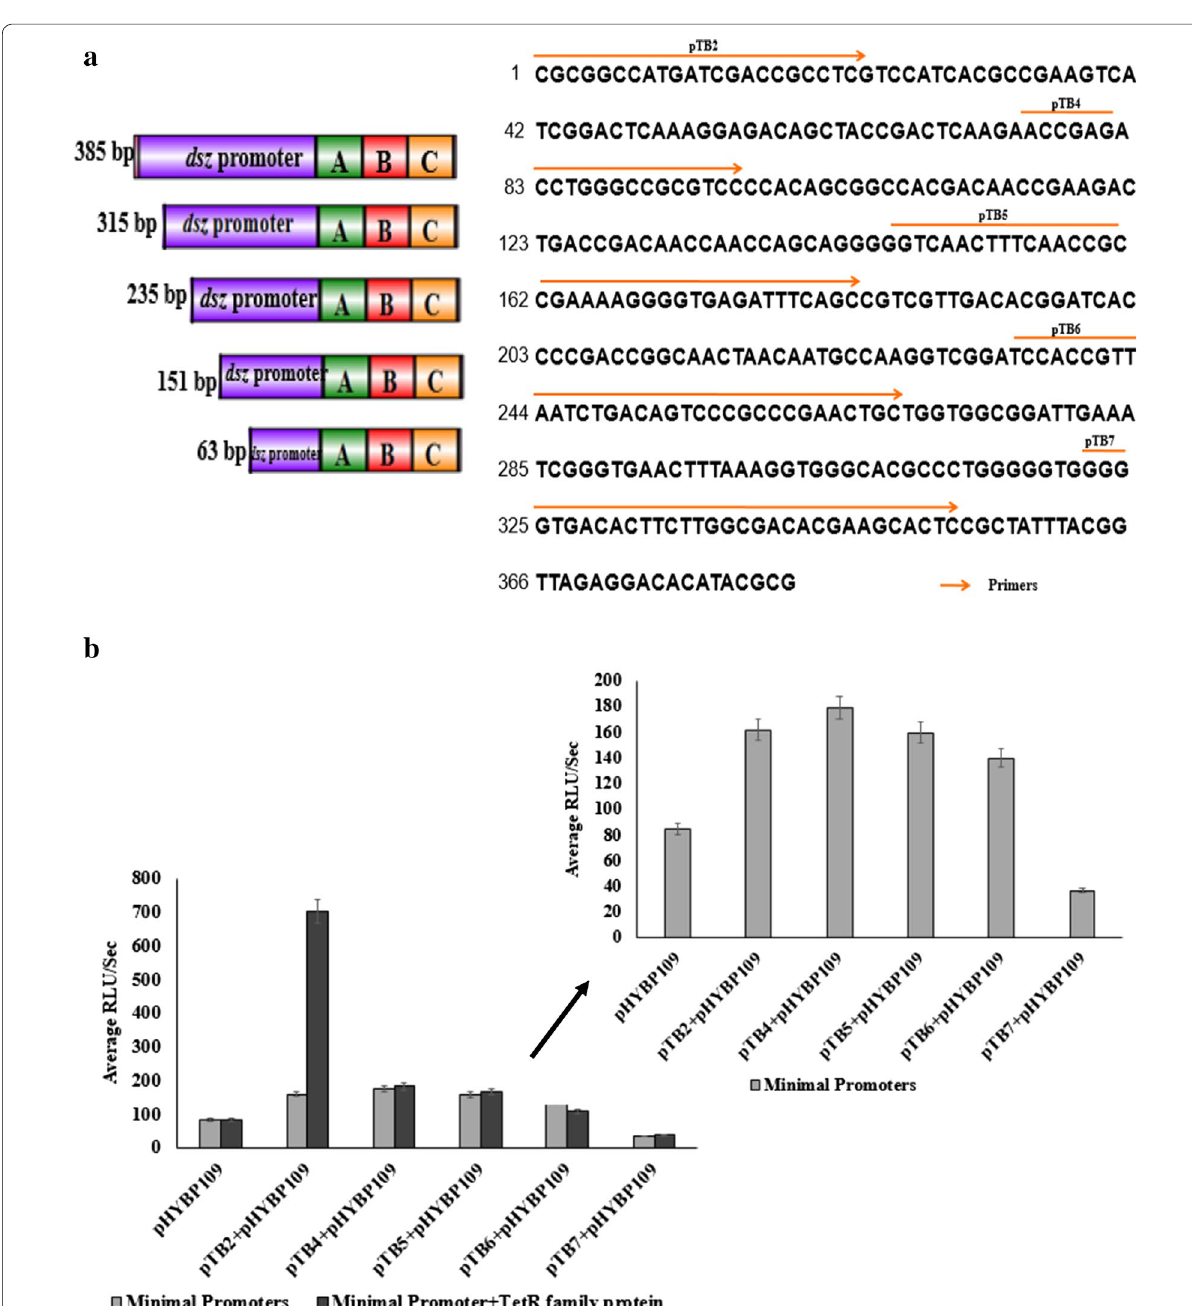
Fig. 8 a Representative figure of the different deletion derivatives of the 385 bp dsz promoter. b Graph showing luciferase assay in recombinant E. coli BL21(DE3) pLysS harbouring full length promoter (pTB2) or deletions of promoter (pTB4–7) along with plasmid pHYBP109 (light grey bar) and in the presence of the TetR family transcription regulator (dark grey bars). Plasmid pTB2 harbour full length 385 bp promoter. Plasmid pTB4, 5, 6 and 7 contain 315 bp, 235 bp, 151 bp and 63 bp promoter fragments. Determination of minimal promoter activity using luciferase assay is represented